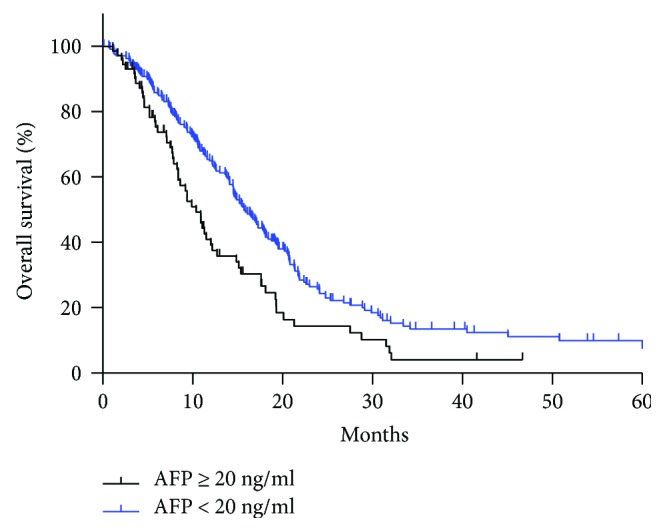
The median OS of group 1 (AFP ≥ 20 ng/ml GCLM) and group 2 (AFP < 20 ng/ml GCLM) was 10.9 m and 15.7 m, respectively (P = 0.002).